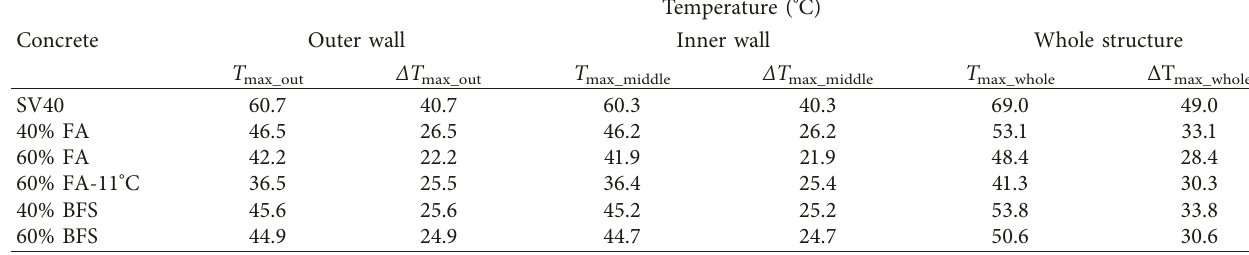
Table 7: Calculated temperatures and the increase of